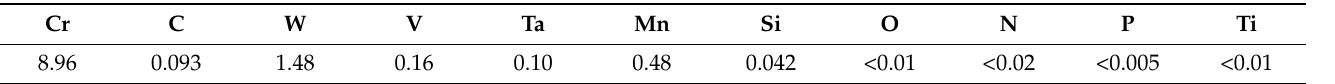
Table 2. RAFM steels properties used in the simulation.